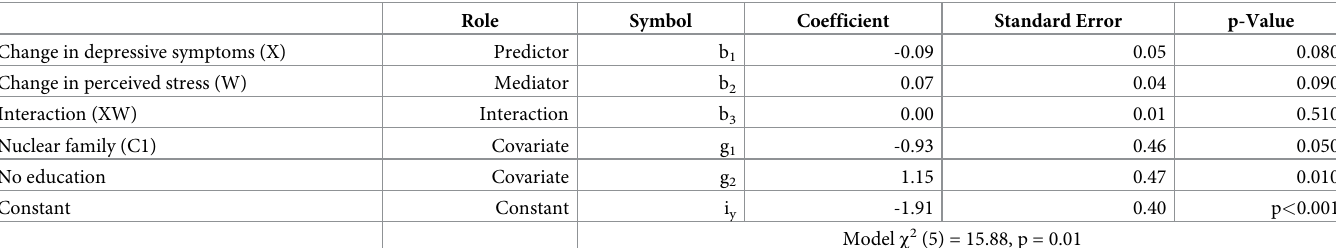
Table 4. Regression analysis examining the moderation of the effect of change in depressive symptoms on preterm birth by change in perceived